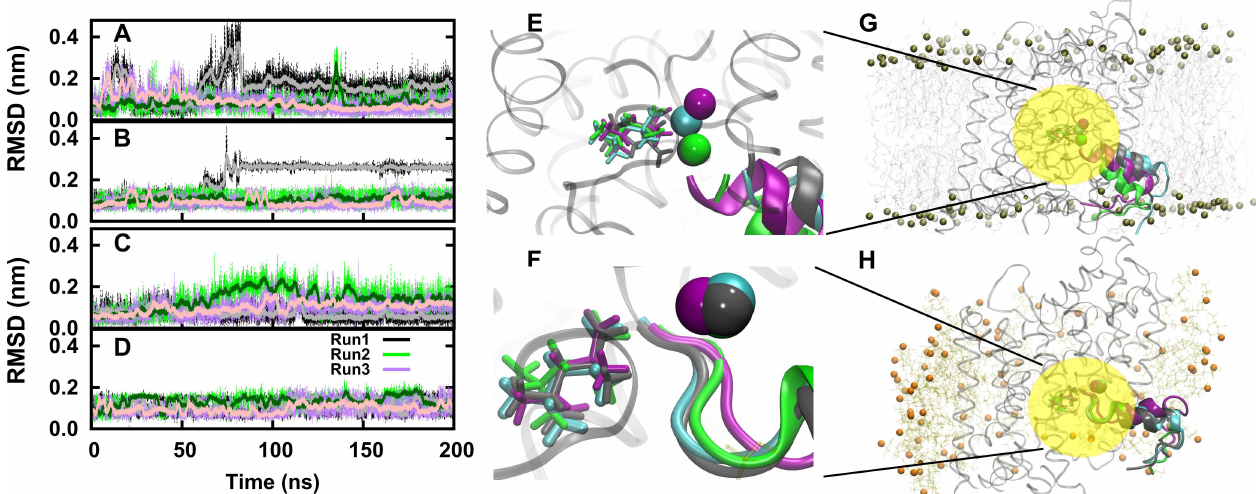
Fig 4. Movement of sodium 1 and substrate of the inward-open conformation. Panels A, B show the displacement of sodium 1 and substrate from three independent simulationsof the membrane inserted inward-openLeuT. Panels C, D show the respective movement of the micelle embedded LeuT. Panels E-H : The final structures of three independent simulations of 200 ns duration each are shown along with the starting structure for the membrane inserted LeuT in cyan ( E, G ) and micelle embedded ( F, H ). Please note, the final positionsof Na1 are essentially identicalin two (green and gray) simulations in panel